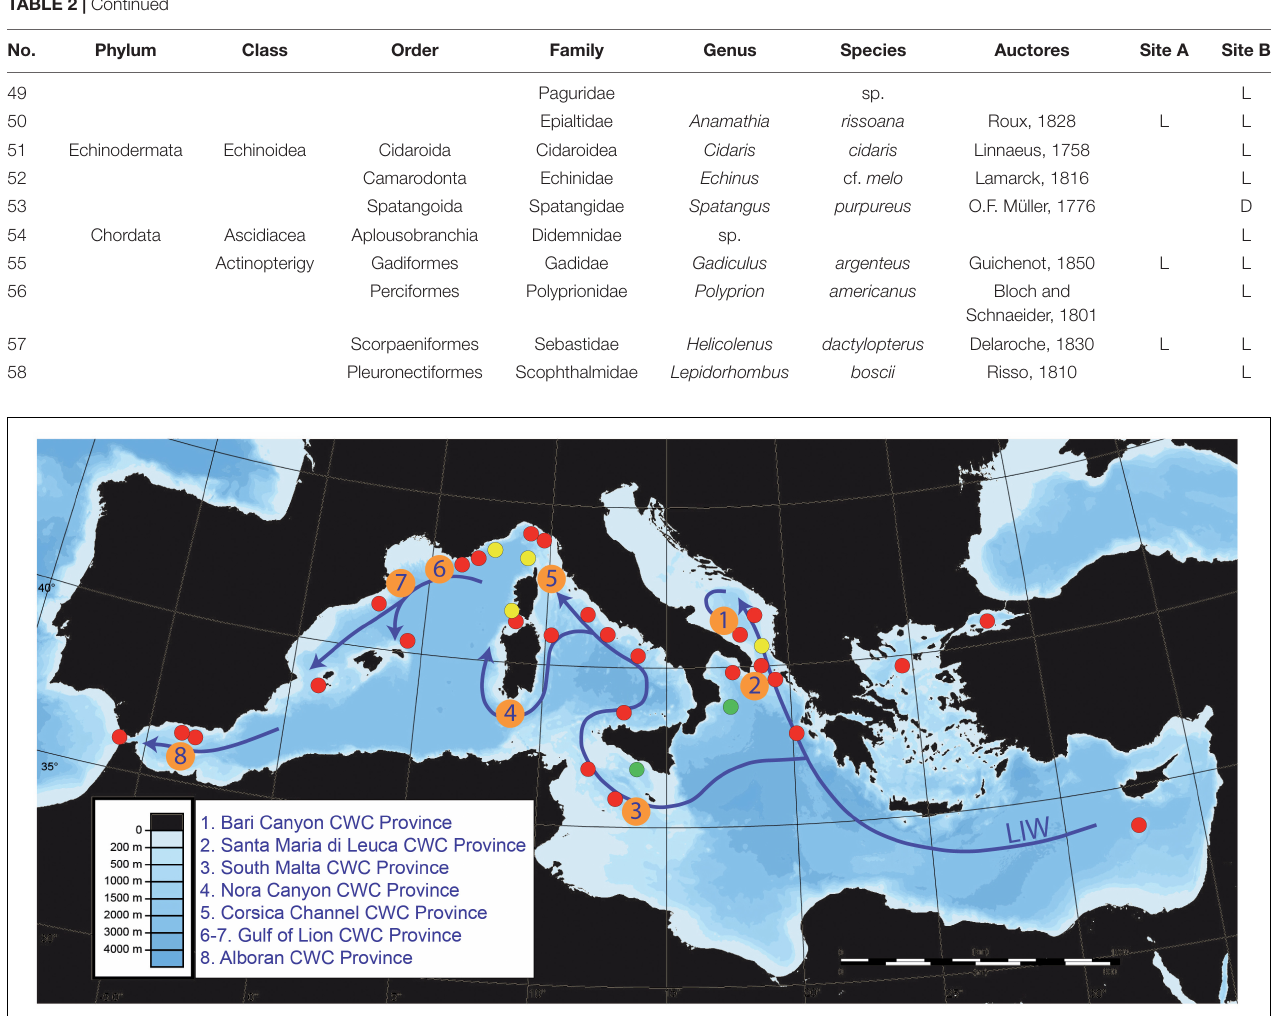
FIGURE 8 | Map of the Mediterranean Sea showing the eight coral provinces (numbered orange dots) and main coral occurrences (red dots) with respect to the main path of the Levantine Intermediate Water (LIW). Yellow dots indicate coral occurrence on anthropic structures (e.g., shipwreck), while green dots on derelict fishing gears. CWC, cold-water